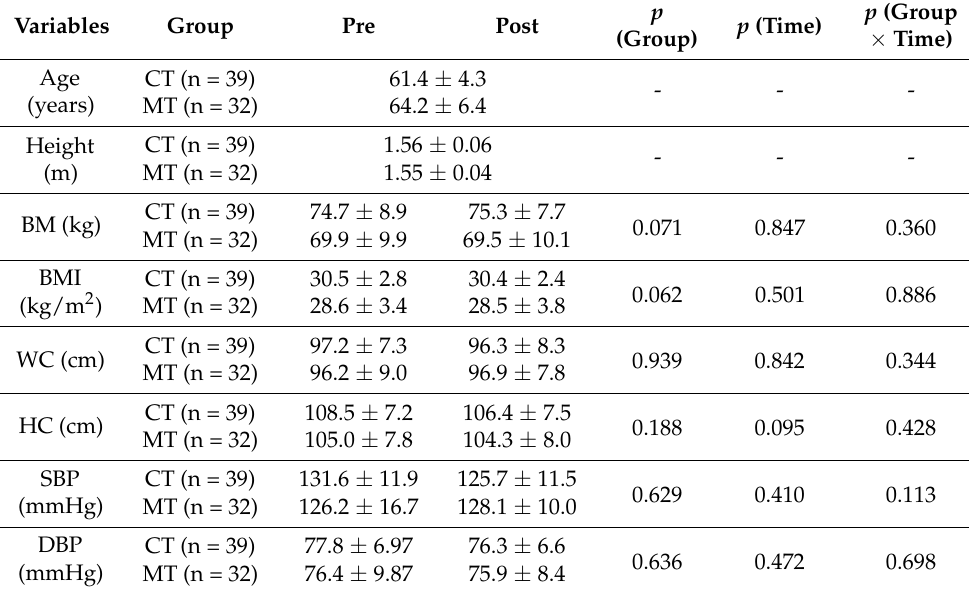
Table 1. Mean ± standard deviation of age, anthropometric measurements, and blood pressure pre- and post-intervention (MT n = 32; CT n = 39). Variables Group Pre Post